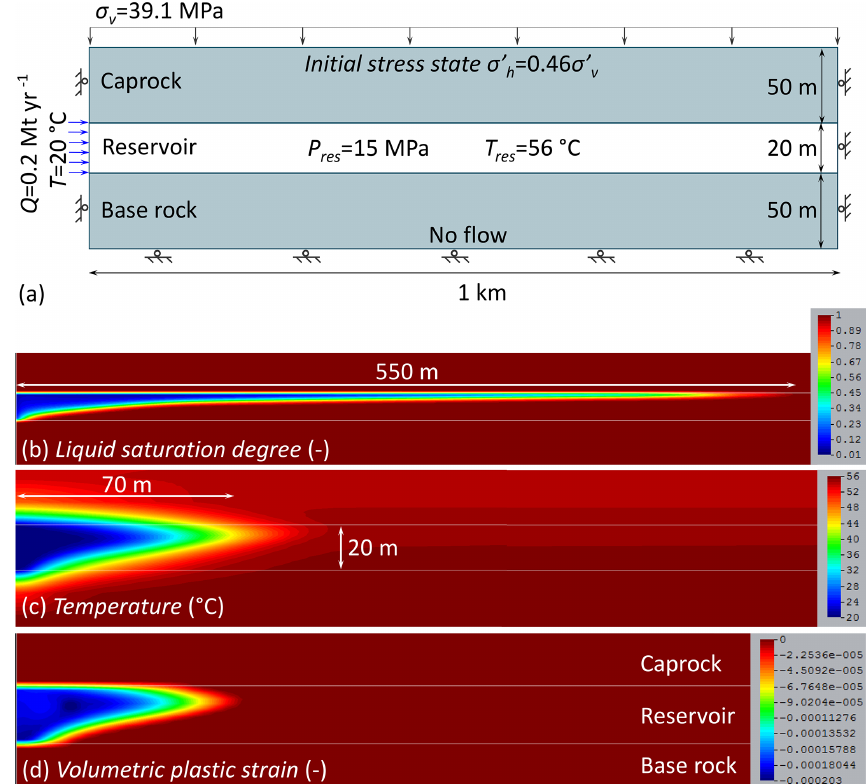
Figure 4. (a) Model setup, (b) liquid saturation degree, (c) temperature distribution and (d) volumetric plastic strain after 2 years of injecting 0.2Mtyr − 1 of CO 2 at 20 ◦ C through a vertical well. While panels (c) and (d) are plotted at the same scale, panel (b) is plotted at a smaller